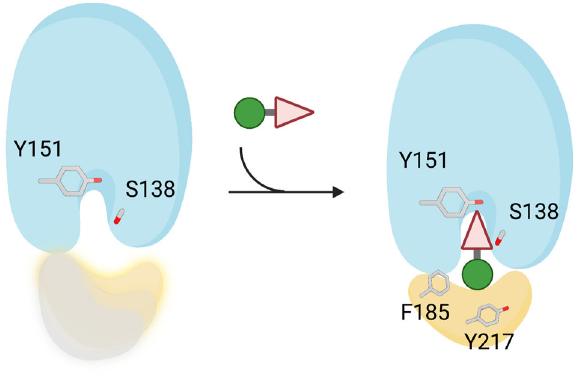
Fig. 6 | Schematic illustrating the proposed mode ofaction involving 15-PGDH inhibition. (+)-SW209415 and SW222746 inhibitors possess different chemical groups that each speci fi cally recognize the catalytic core of 15-PGDH. Binding of inhibitorsubstituents(triangle)tothecatalyticcenter(S138andY151)positionsthe inhibitorwithintheenzyme.Bindingofeitherinhibitortheninducesahydrophobic collapse of residues that form the lid (yellow) of the enzyme binding site to fully encapsulate the inhibitors in the protein binding pocket. The conserved F185 and Y217 residues reside at either end of the 15-PGDH lid and form interactions with other inhibitor substituents (green ball) to maintain the lid in the closed position.